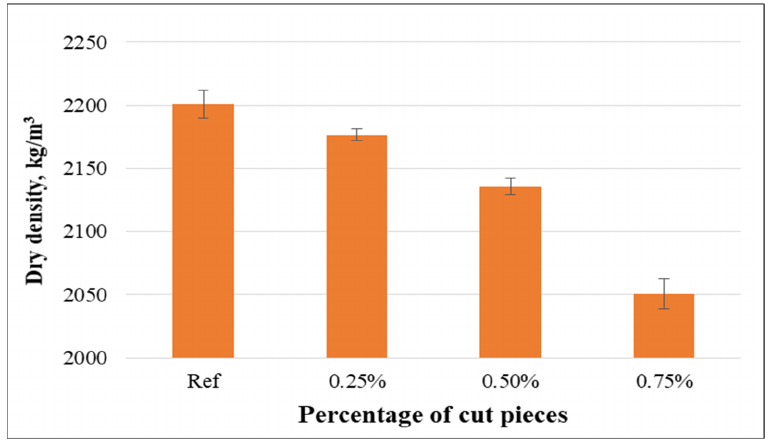
Figure 16. Relationship between dry density and volume fraction of non-woven tissue.